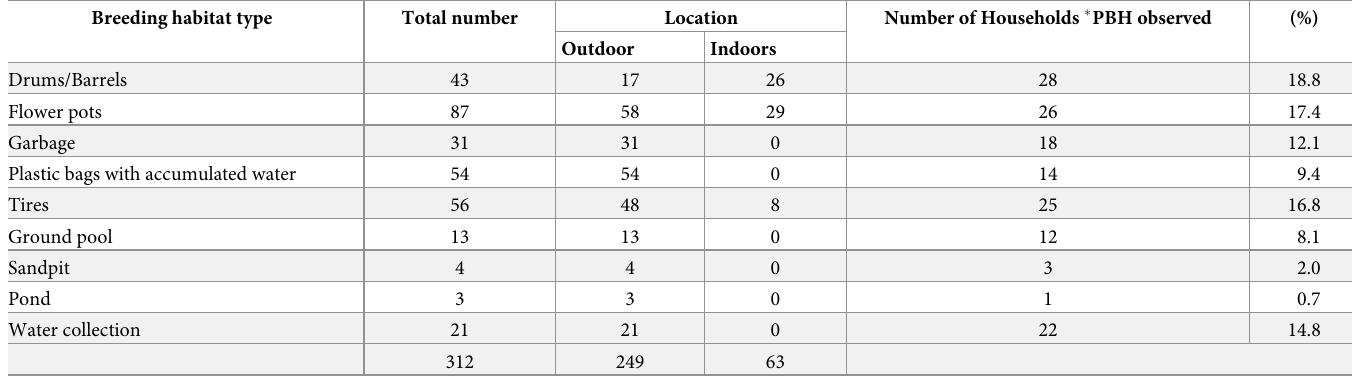
Table 3. Frequency of common Aedes aegypti breeding habitat types across households.